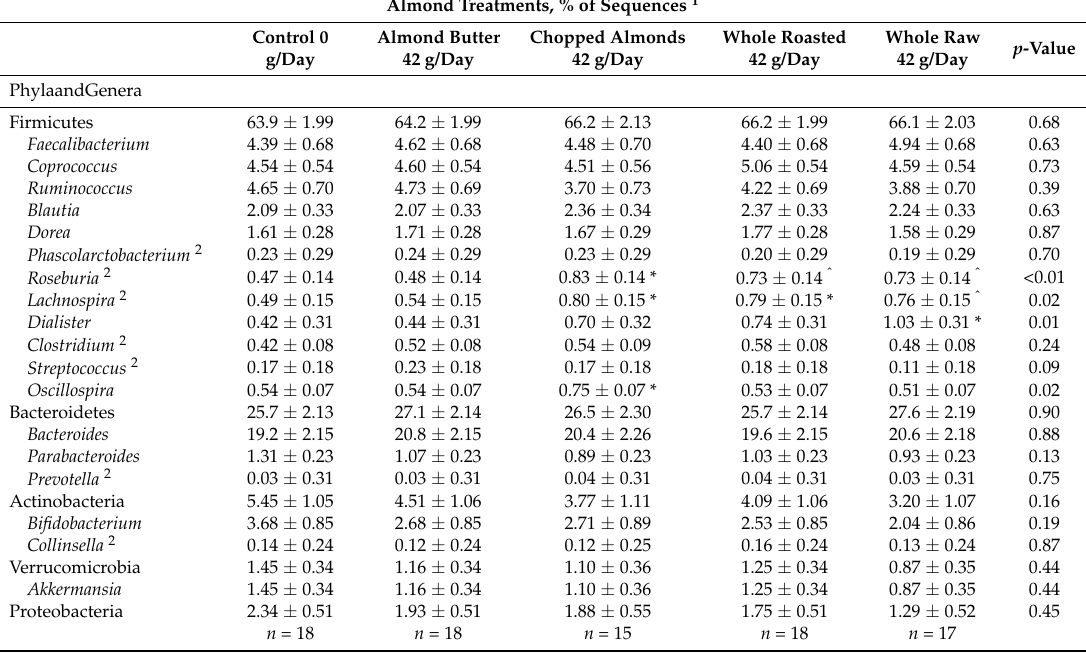
Table 3. Bacterial phyla and genera of human participants at the end of the control diet period and each of the almond diet periods, each for three weeks 1